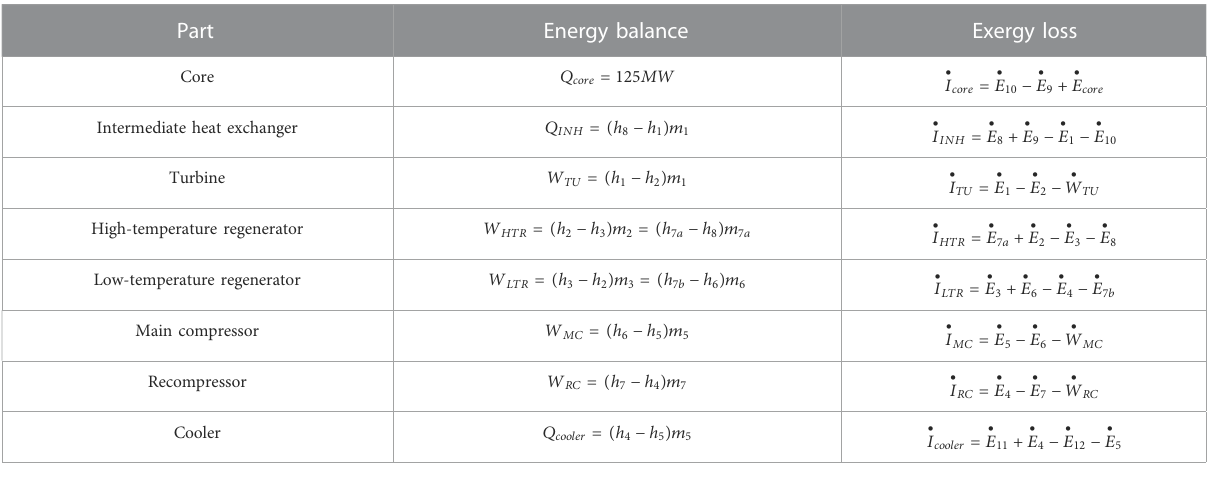
TABLE 3 Energy balance and exergy balance relationship.